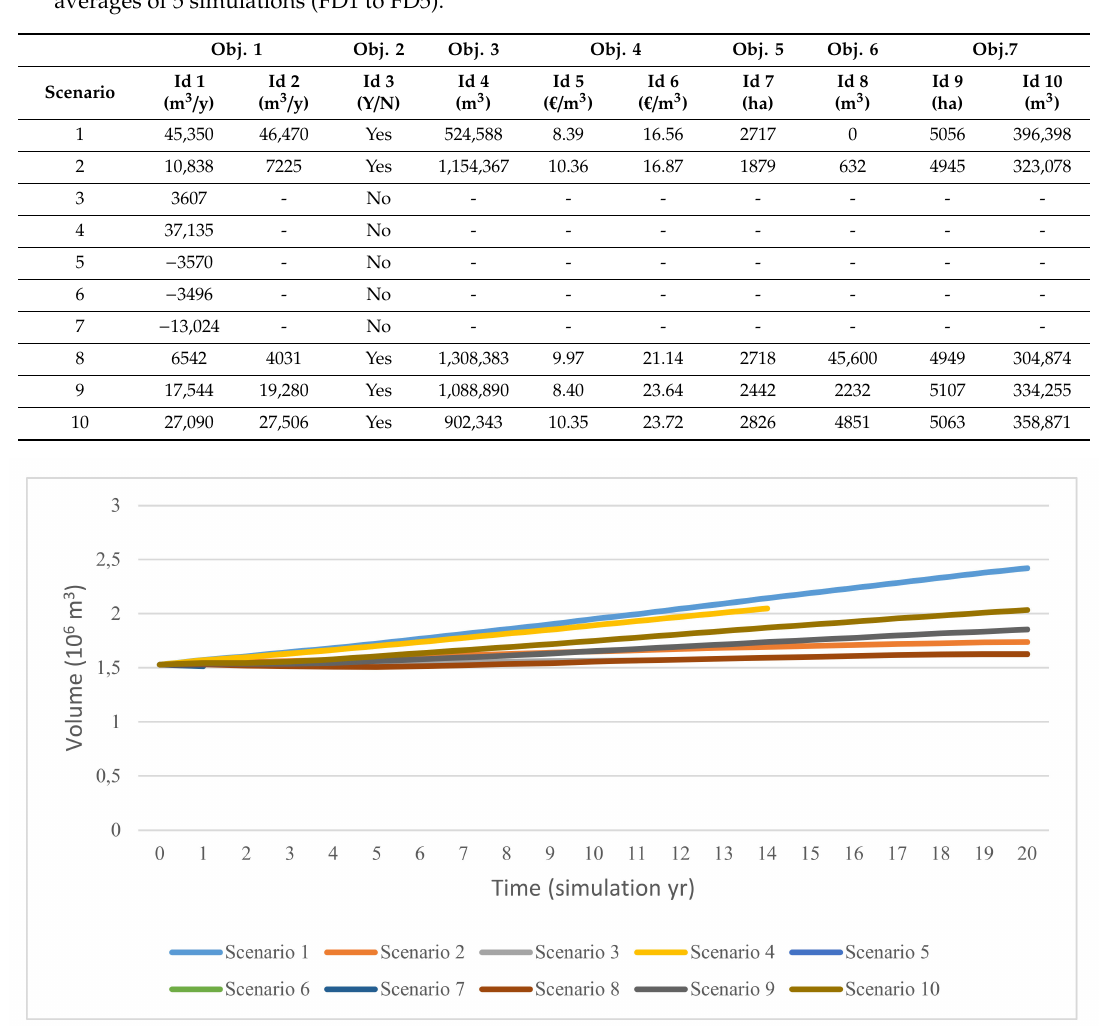
Figure 9. Standing volume (m 3 ) in the study area over the 20-y simulation period in the second simulation for all scenarios considering strict minimum and maximum volume goals (Table A5, Appendix